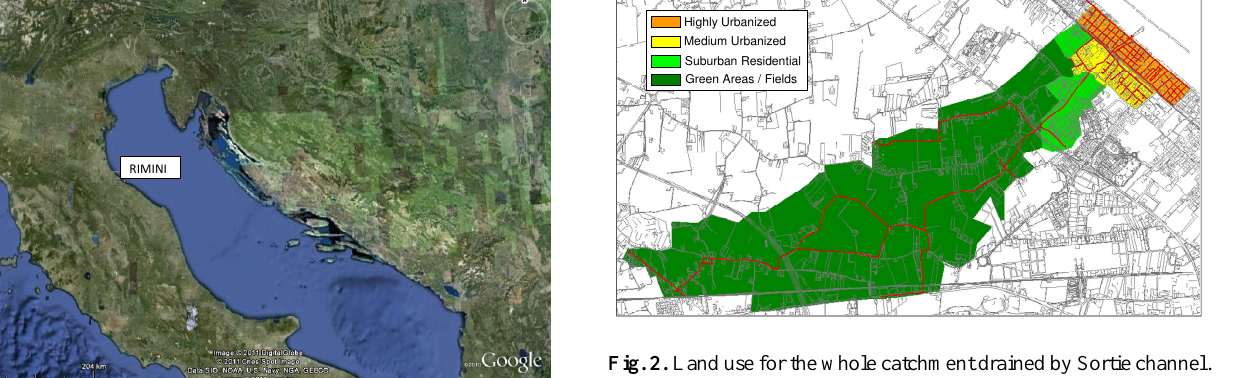
Fig. 2. Land use for the whole catchment drained by Sortie